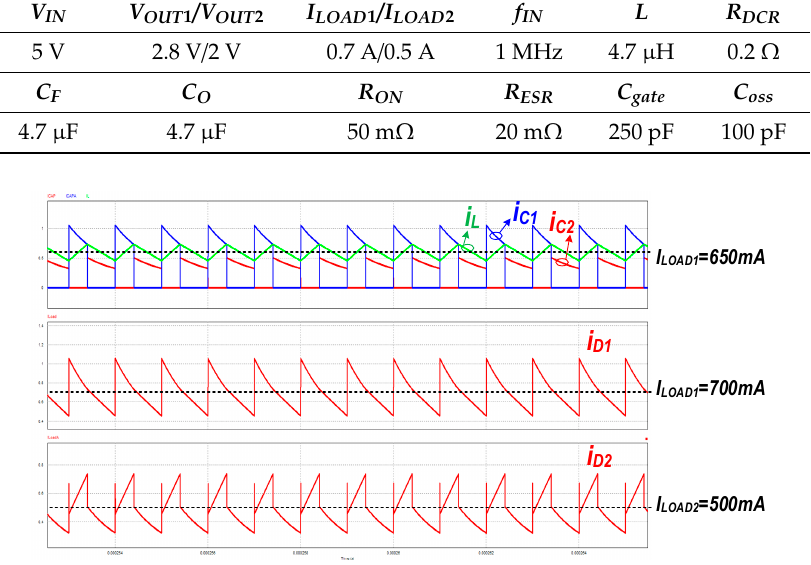
Table 4. Simulation conditions for single-inductor multiple-output (SIDO) converter with ETM.